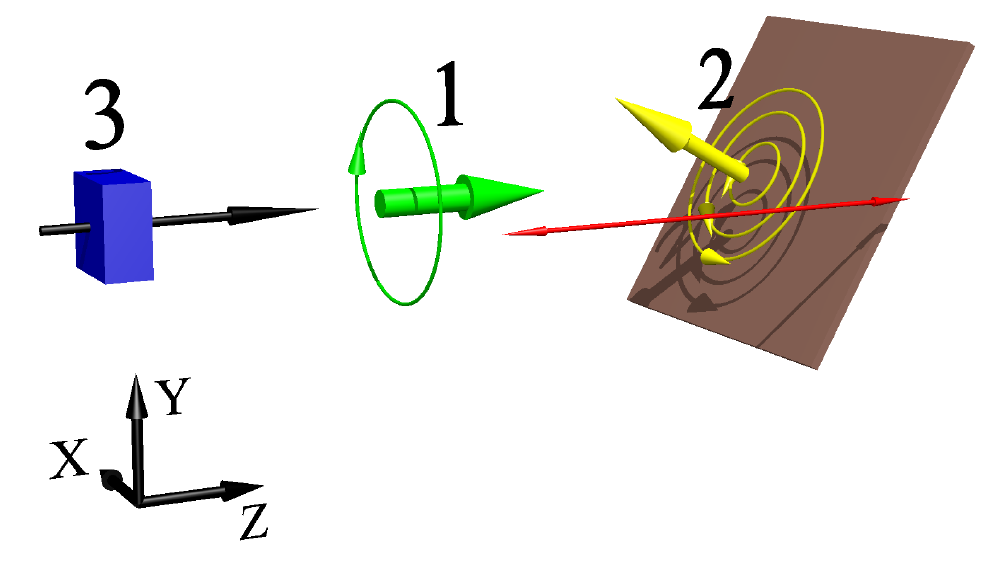
Figure 1. Generic configuration of an inductive measurement arrangement. The primary rf field (green arrow) produced by the rf coil (1) causes the response of the object (2) in the form of a secondary field (yellow arrow). The signal is recorded by a sensor (3). Here, the radio-frequency atomic magnetometer monitors only the components of the secondary field orthogonal to the sensor axis (black arrow). Lift-off, distance between primary field source and object, is labelled by the red arrow. Concentric yellow circles represent eddy currents, that have mainly surface character. In general, there could be also a component produced by object magnetisation that exhibits volume